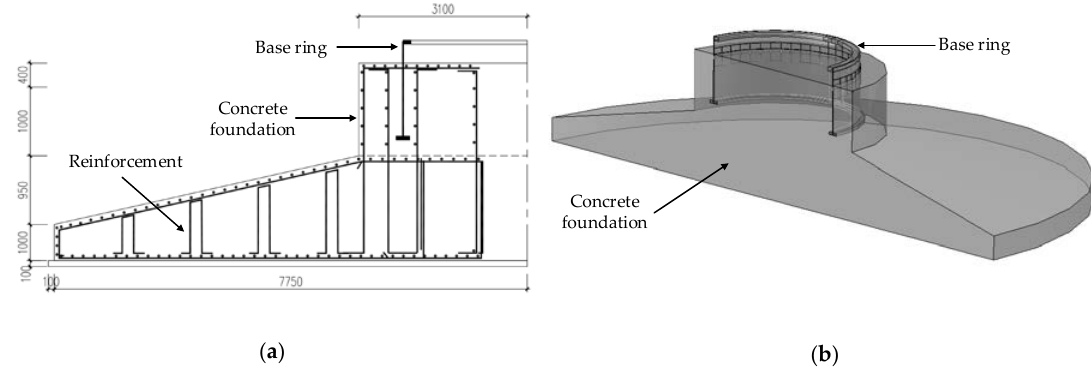
Figure 3. 1.5 MW wind turbine foundation: ( a ) foundation size (mm); ( b ) half-section stereogram of the prototype foundation.